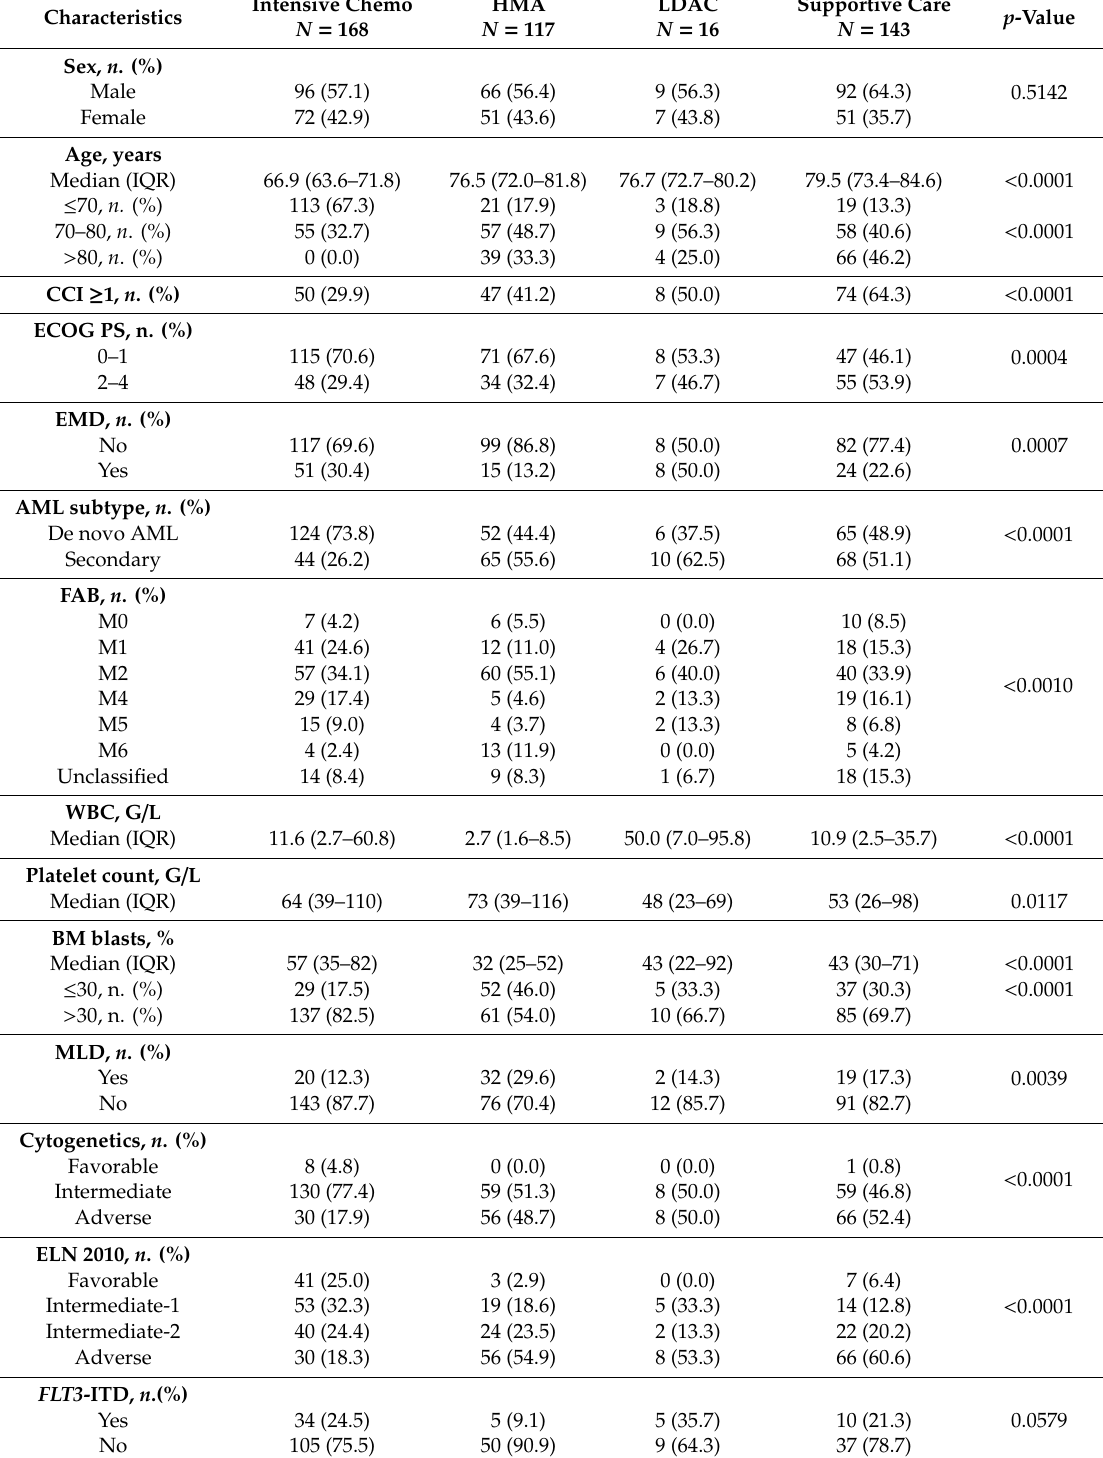
Table 1. Characteristics of AML patients ≥ 60 years according to treatment